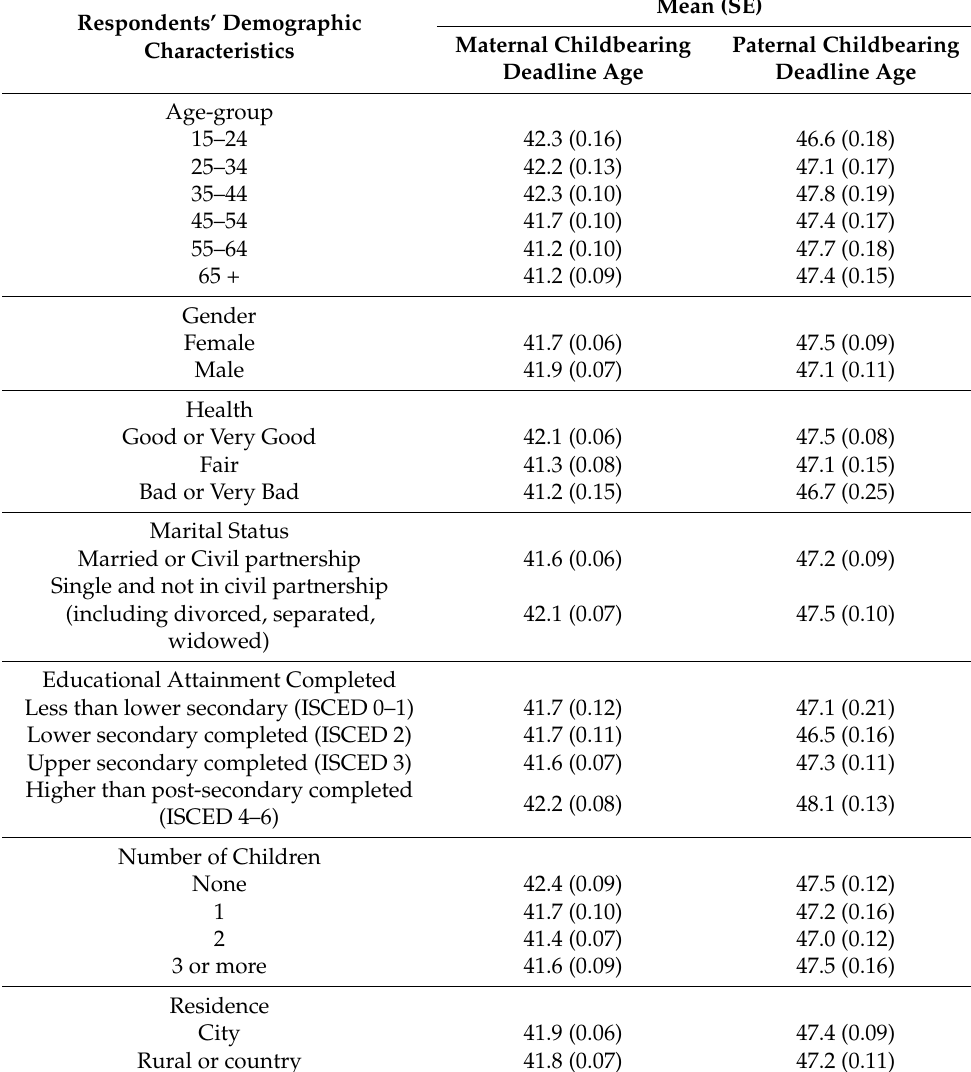
Table 1. Respondents’ perception of maternal and paternal childbearing deadline ages by demo- graphic